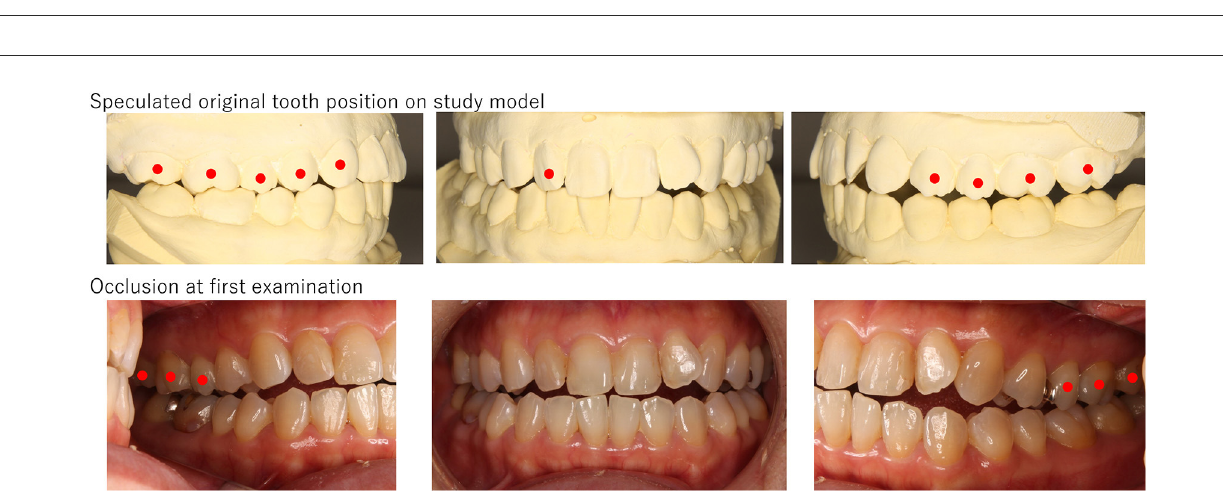
FIGURE2 The picture of a patient (Case No. 5). Slight open bite was observed with no occlusal contact from the right first premolar to the left first premolar, and the mandibular slightly shifted to the right. The presence of facets and reconstruction on the study model revealed her mandibular shifted to anteroinferior, and consequently, open bite was presented. Red circles indicate teeth which have occlusal